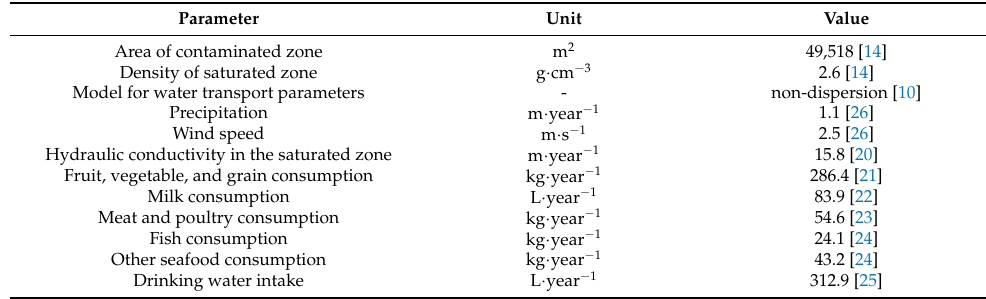
Table 3. List of input parameters related to the characteristics of the Wolsong NPP